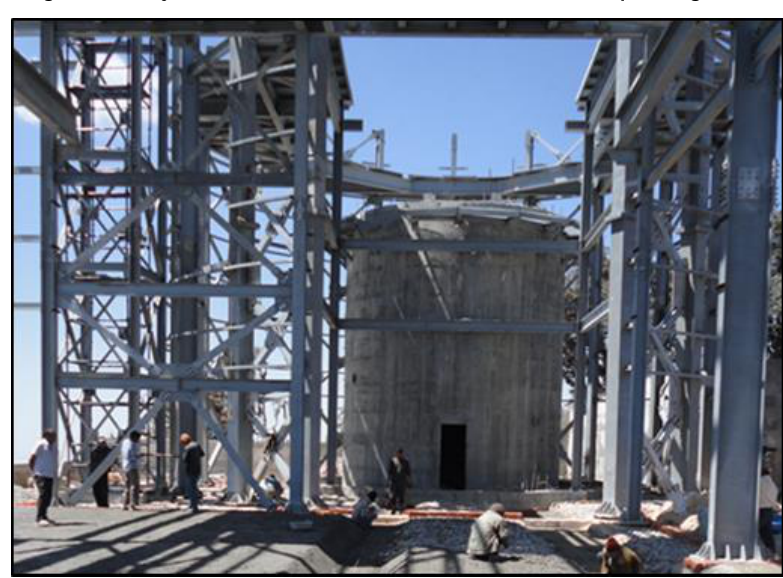
Figure 6. Hollow cylindrical concrete pier constructed at